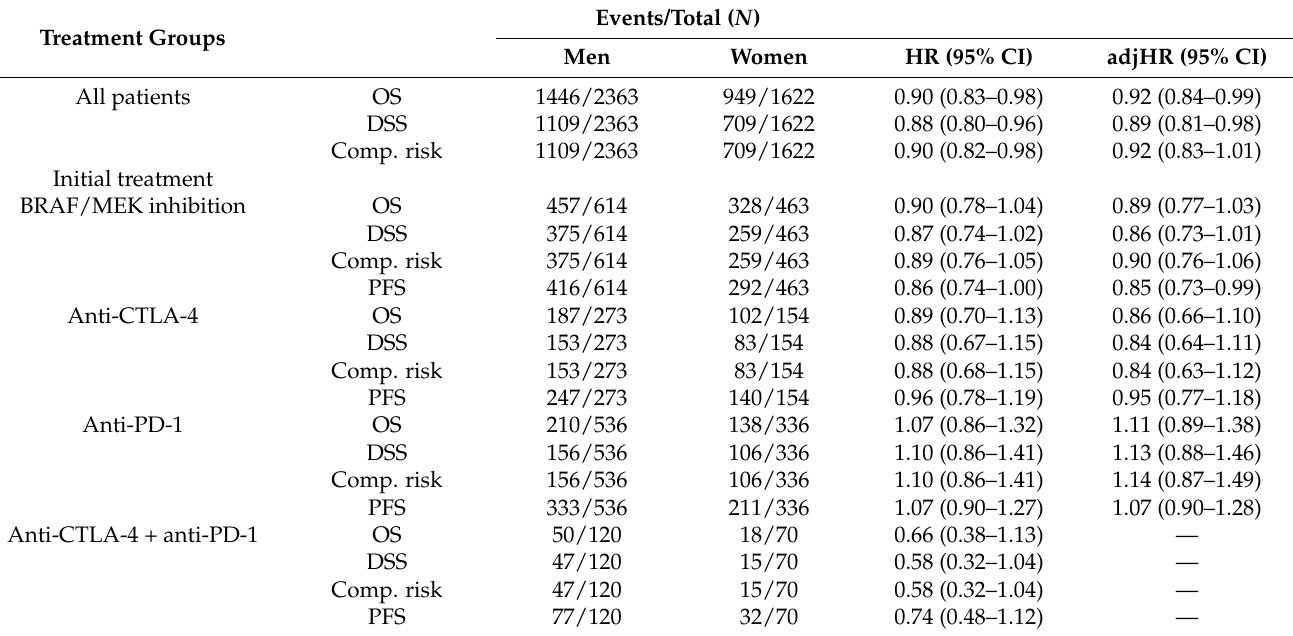
Table 3. Survival of female compared to male patients following initial systemic treatments. Treatment